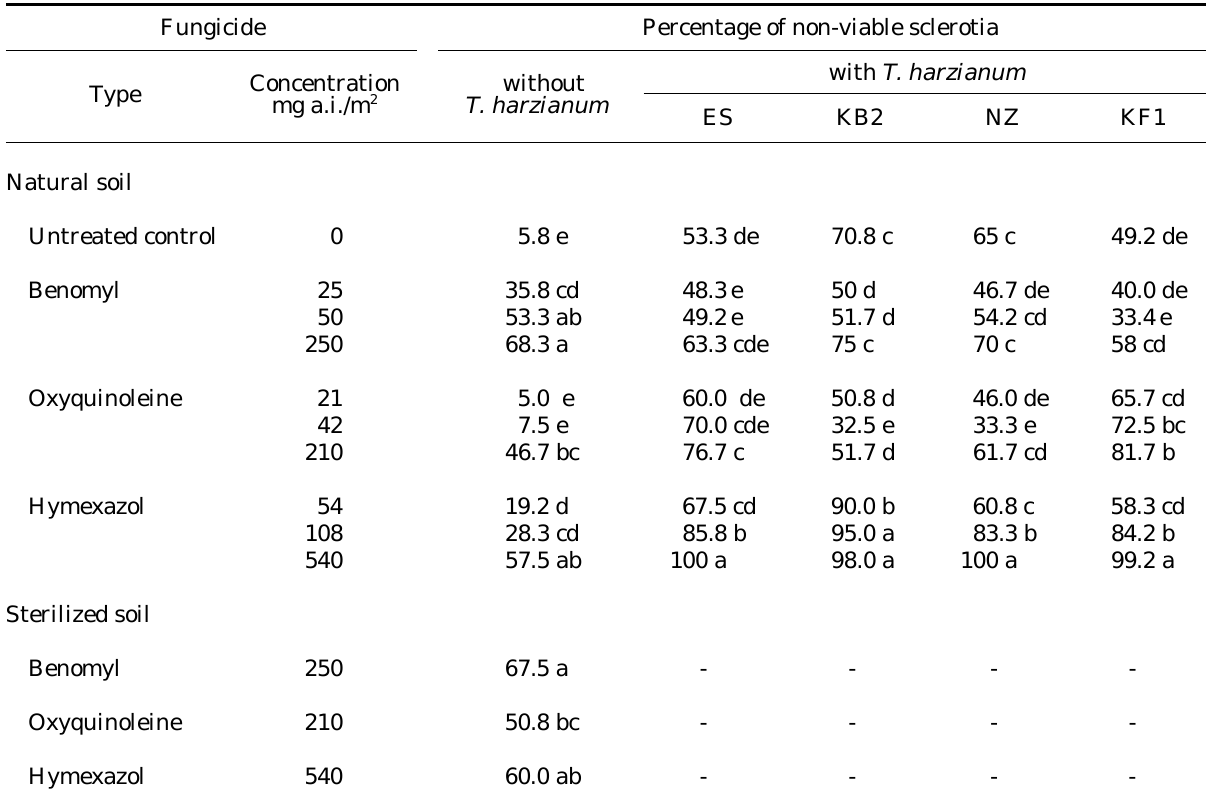
Table 1. Effect of fungicide plus one of four Trichoderma harzianum isolates (ES, KB2, NZ, KF1) on sclerotia viabil- ity in soil after four weeks of incubation at 28 (cid:176)